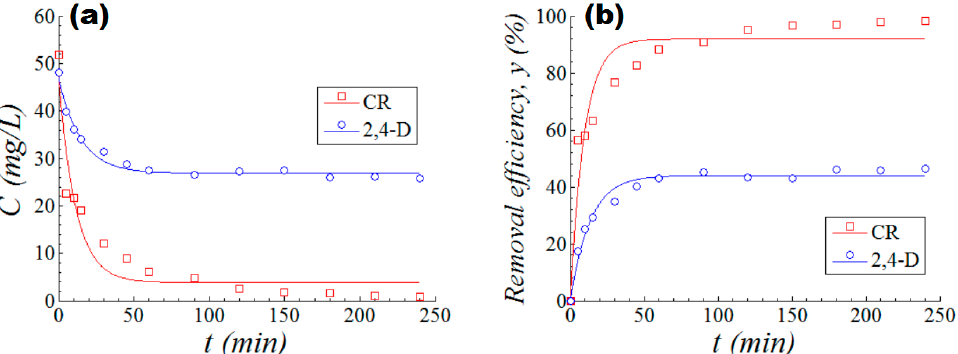
Figure 8. Photodegradation of organic pollutants in aqueous solutions in the presence of the M5 catalyst sample; ( a ) concentration decay of CR and 2,4-D pollutants against reaction time; ( b ) removal efficiency evolution on the course of the photodegradation; conditions: initial pollutant concentration 50.0 ± 0.5 mg/L, dosage of catalyst 0.167 g/L, T = 20 ± 2 ° C, pH 6.8 ± 0.2, V R = 600 mL; (solid lines denote predictions given by pseudo first-order kinetic models).